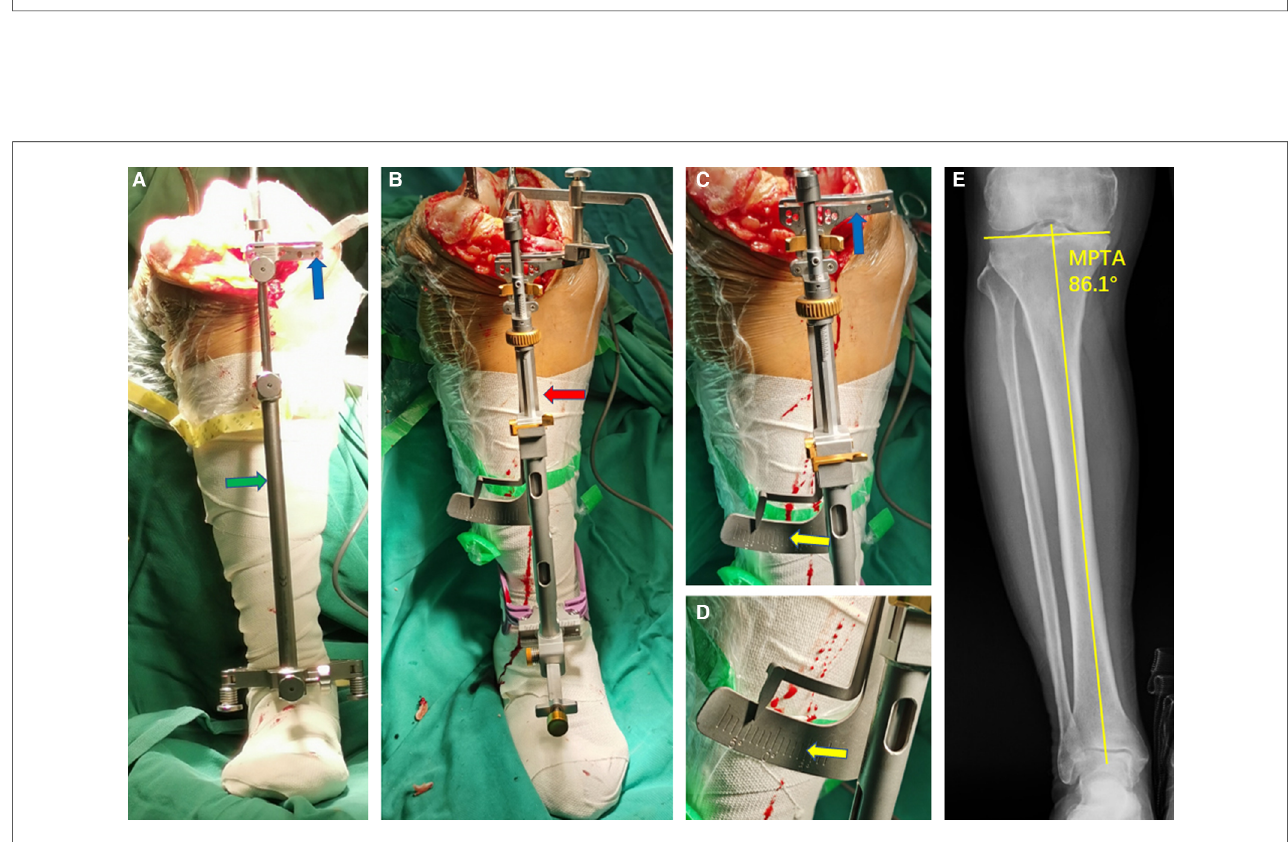
FIGURE 2 Tibial extramedullary assembly and its application ( A for MA; B – D for KA). ( A ) Standard MA tibial extramedullary assembly. The extramedullary reference rod (green arrow) was set parallel to the mechanical axis of the tibia, and the proximal tibia cutting block (blue arrow) was perpendicular to the tibial mechanical axis. ( B ) The extramedullary reference rod of the speci fi c KA instrument (red arrow) was also set parallel to the mechanical axis of the tibia. ( C ) The extramedullary assembly of the speci fi c KA instrument has an angular scale (yellow arrow) in conjunction with the cutting block (blue arrow), which guaranteed an equal-angle linkage mechanism. ( D,E ) The angular scale (yellow arrow) can be adjusted in the range of ±8° in varus or valgus. Usually, the angular scale was set in accordance with preoperative MPTA to restore the native joint line inclination in the coronal